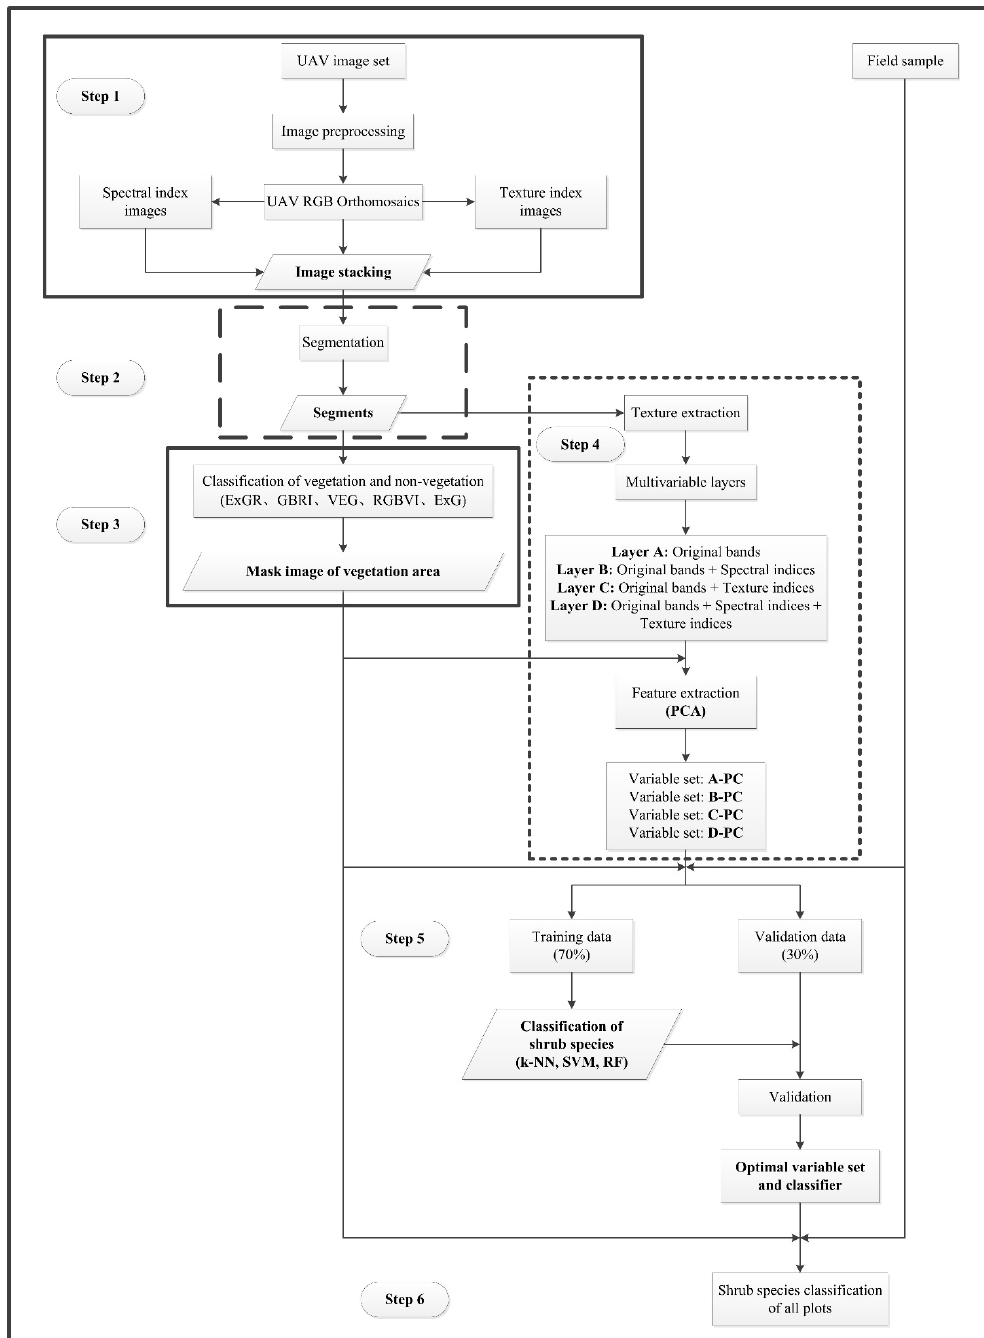
Figure 4. Workflow for classification of individual shrub species. Abbreviations used in the classification step: excess green red index (ExGR), green blue ratio index (GBRI), vegetative index (VEG), red green blue vegetation index (RGBVI), excess green index (ExG), k-nearest neighbors (k-NN), support vector machine (SVM), random forest (RF), principal component analysis (PCA). The A-PC, B-PC, C-PC, and D-PC represent the sets of variables used in the classification experiments of shrub species after principal component analysis (PCA) of layers A, B, C, and D,